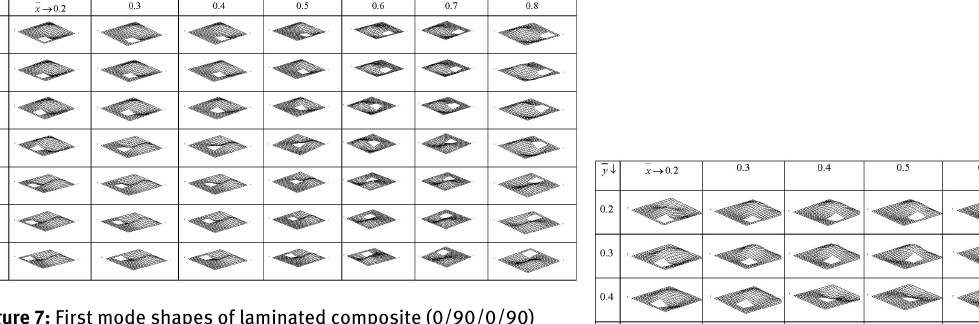
Figure 7: First mode shapes of laminated composite (0/90/0/90) stiffened elliptic parabolic shell for different position of the central square cutout and CCSC boundary condition.